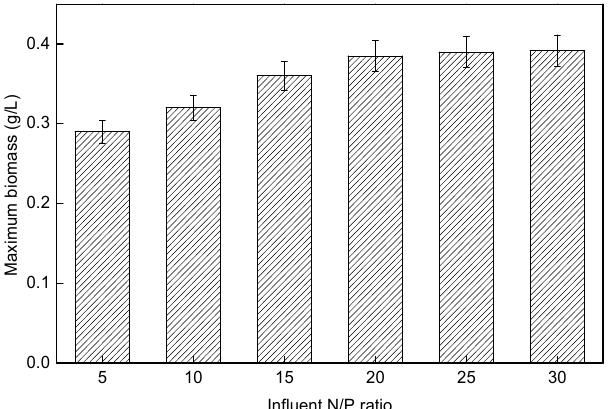
Figure 9. The P. helgolandica tsingtaoensis biomass of reactors under different influent N/P ratios at the 20th day.